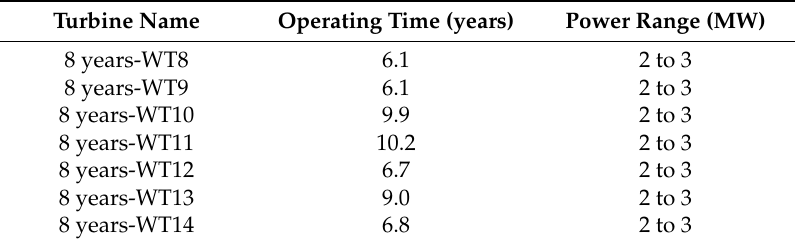
Table 8. Turbine data of the eight-year group for trend analysis with PAO